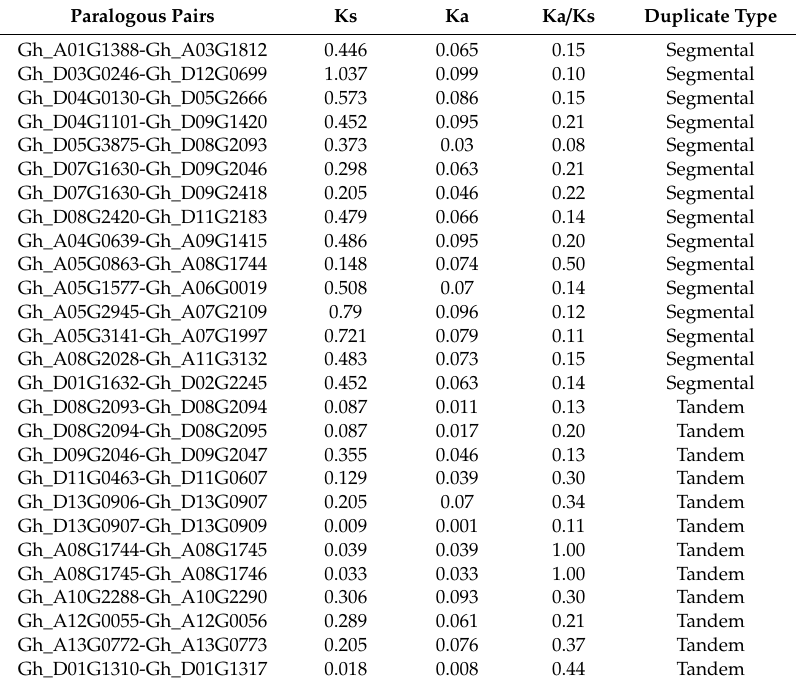
Table 2. The Ka, Ks, and Ka / Ks values for the 27 gene